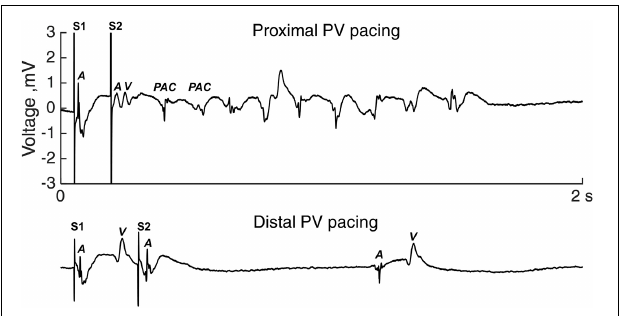
FIGURE 5 | Atrial arrhythmias induction. Electrogram tracings of premature S2 stimulation in the proximal PV (upper panel) and the distal PV (lower panel). The S1-S2 coupling intervals equaled the local refractory period. A, atrial activation; PAC, premature atrial complex; V, ventricular